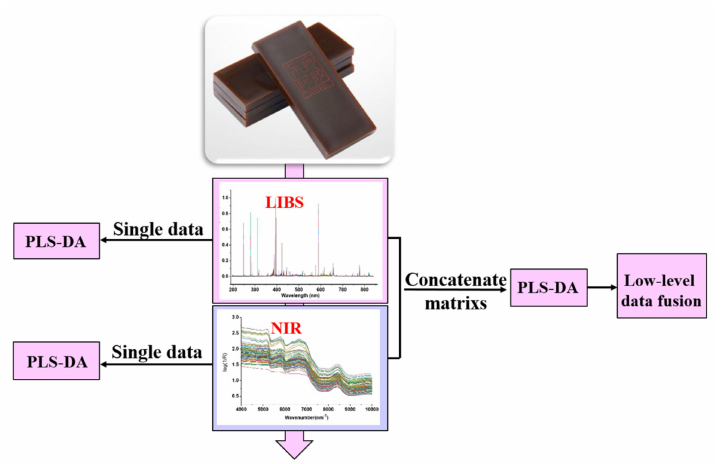
Figure 6. The scheme of data